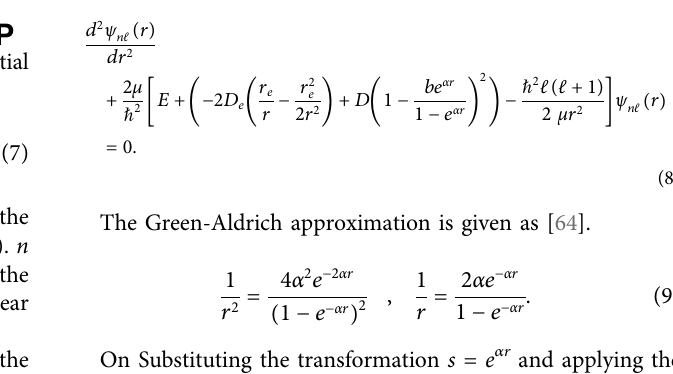
Frontiers in Physics |